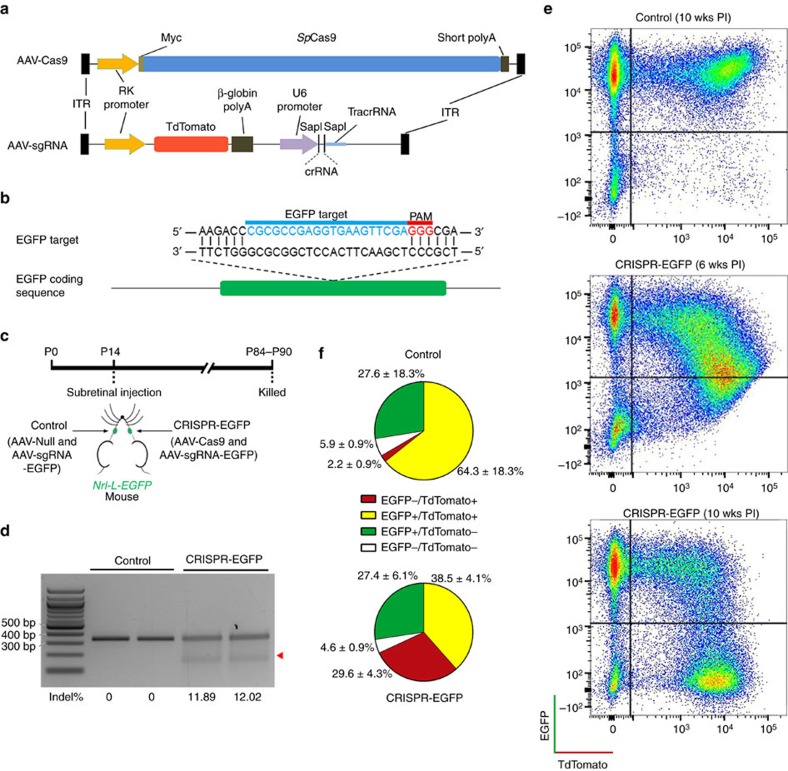
EGFP knockdown in photoreceptors by an AAV-CRISPR/Cas9 system.(a) Schematic representation of the AAV vectors delivering SpCas9 and sgRNA. (b) Schematic representation of the EGFP locus showing the location of the sgRNA target. The targeted genomic site is indicated in blue. Protospacer adjacent motif (PAM) sequence is marked in red. (c) Timeline for the EGFP knockdown experiments. Each Nrl-L-EGFP mouse was subretinally injected with 2.5 × 109 vector genomes (vg) AAV-Cas9 and 2.5 × 109 vg AAV-sgRNA-EGFP in one eye, and the same doses of AAV-Null and AAV-sgRNA-EGFP (control) in the fellow eye. A total of eight mice including both genders were used. (d) SURVEYOR nuclease assay revealing indel formation at the EGFP locus in flow-sorted tdTomato-expressing cells. Each lane contained sample from an individual mouse (n=2). DNA fragments digested by SURVEYOR nuclease are indicated by arrowhead. Indel rate of each sample is shown below the gel image. (e) Representative FACS plots of dissociated cells from retinas receiving control vectors (upper panel) or CRISPR-EGFP vectors (middle and lower panels). Dissociated cells from two retinas were used in each group. (f) Statistical analysis of flow-sorted retinal cells of three independent experiments. Data are represented as mean±s.d. PI, post injection.